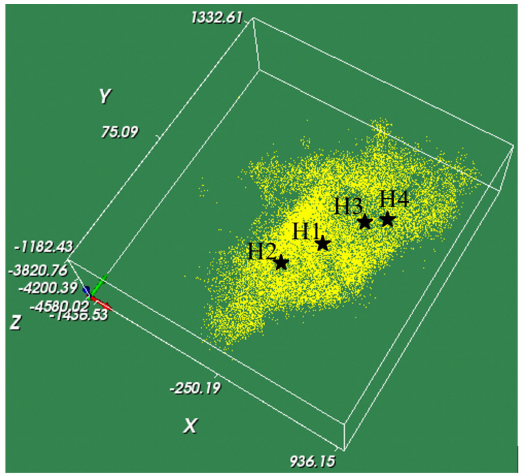
Figure 18. Absolute hypocentre locations of the seismic